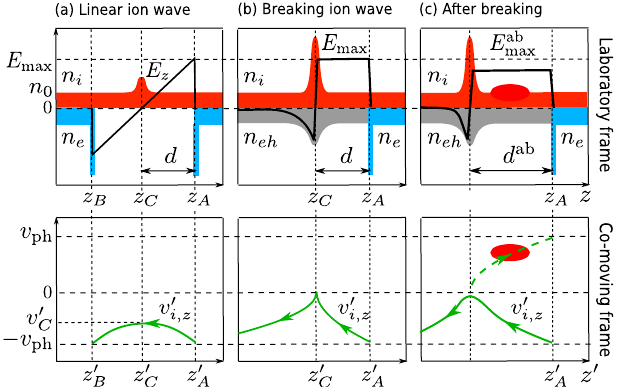
simulations.FIG. 2. Schematic figure of ion dynamics, modeling the results of Fig. 1. Density distribution of ions ( n i ), cold electrons ( n e ), and heated electrons ( n eh ) are denoted by red, blue, and gray areas, respectively. The charge separation electric field E z along the propagation direction is denoted by black solid lines. The lower panels show trajectories (green lines) in ion phase space ð z; v i;z Þ in a frame (marked by apostrophes) comoving with the wake at phase velocity v . Column (a) refers to ion waves with small ph amplitude, where ions just pass through, while (b) refers to a breaking ion wave where ion velocity just reaches v , and FIG. 3. 1D model and simulation results. (a) Peak ion energy ph E (c) refers to a stage after breaking when background ions have i; peak (color scale) obtained from simulations plotted in plane of been partially injected and are accelerated to the right (indicated laser amplitude a 0 and density n 0 =n c . The black solid line shows by a red spot). The wakefield is then more expanded and weaker the onset of IWBA derived from Eqs. (2) – (3), the black dashed such that further injection is suppressed. In cases (b) and (c), the line denotes the border to hole-boring (HB) (full ion trapping) as downstream cold electron layer has disappeared, and a charge obtained from simulations. (b) Maximum of peak ion energy E a double layer wakefield has formed between the laser-driven front i; peak versus 0 ; red circles from simulations, black solid line electrons and the trailing ions; it is modeled by width d and from Eqs. (1) – (3), blue thin dashed line from HB model [21]. constant field E in (b), and d ab and E ab in (c) Laser propagation velocity β and (d) peak ion energy E i; max max ph peak as a function of density n 0 =n c for a 0 ¼ 44 (red thick solid line), a ¼ 20 (green thick broken line), and a ¼ 8 (blue thick dotted 0 0 line) obtained from simulation. The corresponding thin lines show the HB model. The black crosses in (c) denote β at IWBA ph threshold as obtained from